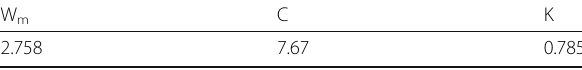
Table 8 GAB parameters used based on DVS of SDF